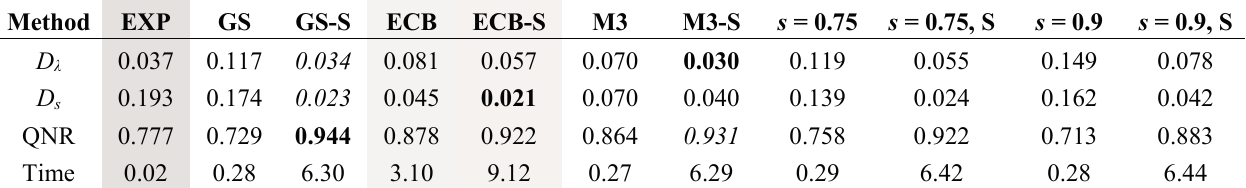
Table 4. Quantitative comparison of the fusion results to check Alparone’s protocol for the QuickBird dataset at full scale, i.e ., at 0.6 m. Time is measured in minutes. The font face indicators are identical to those in Table 2.